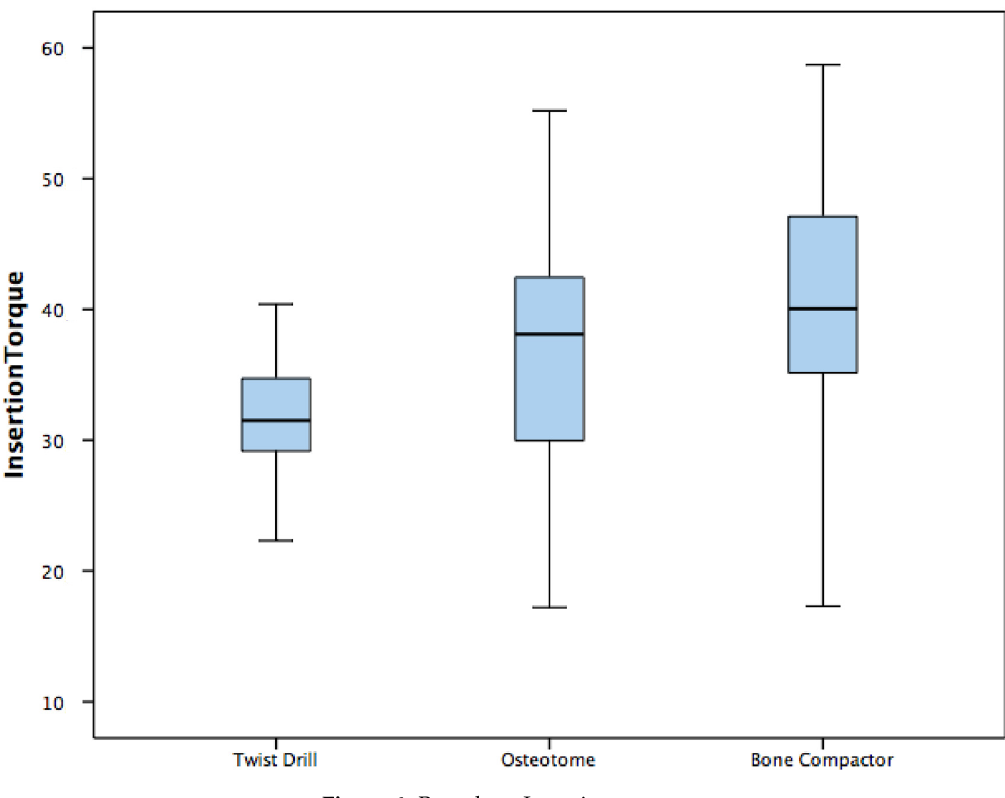
Figure 6. Box plot—Insertion torque.